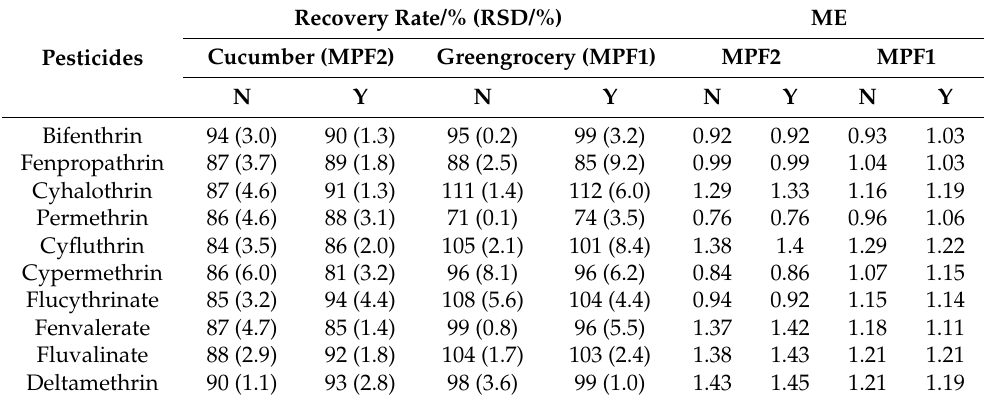
Table 1. Influence of centrifugation on the recovery rate and matrix effect of pyrethroid pesticides.